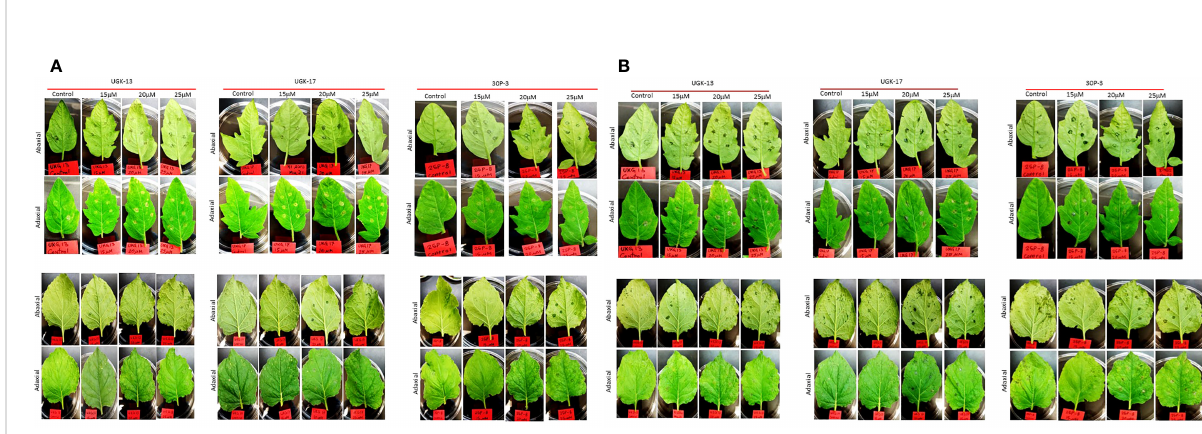
FIGURE 3 Toxicity monitoring after in fi ltration with different peptides at 15 – 25 m M concentration for 24 and 96 h. (A) Tomato leaves ( top ) and tobacco leaves ( bottom ) for 24 h. (B) Tomato leaves ( top ) and tobacco leaves ( bottom ) for 96 h.